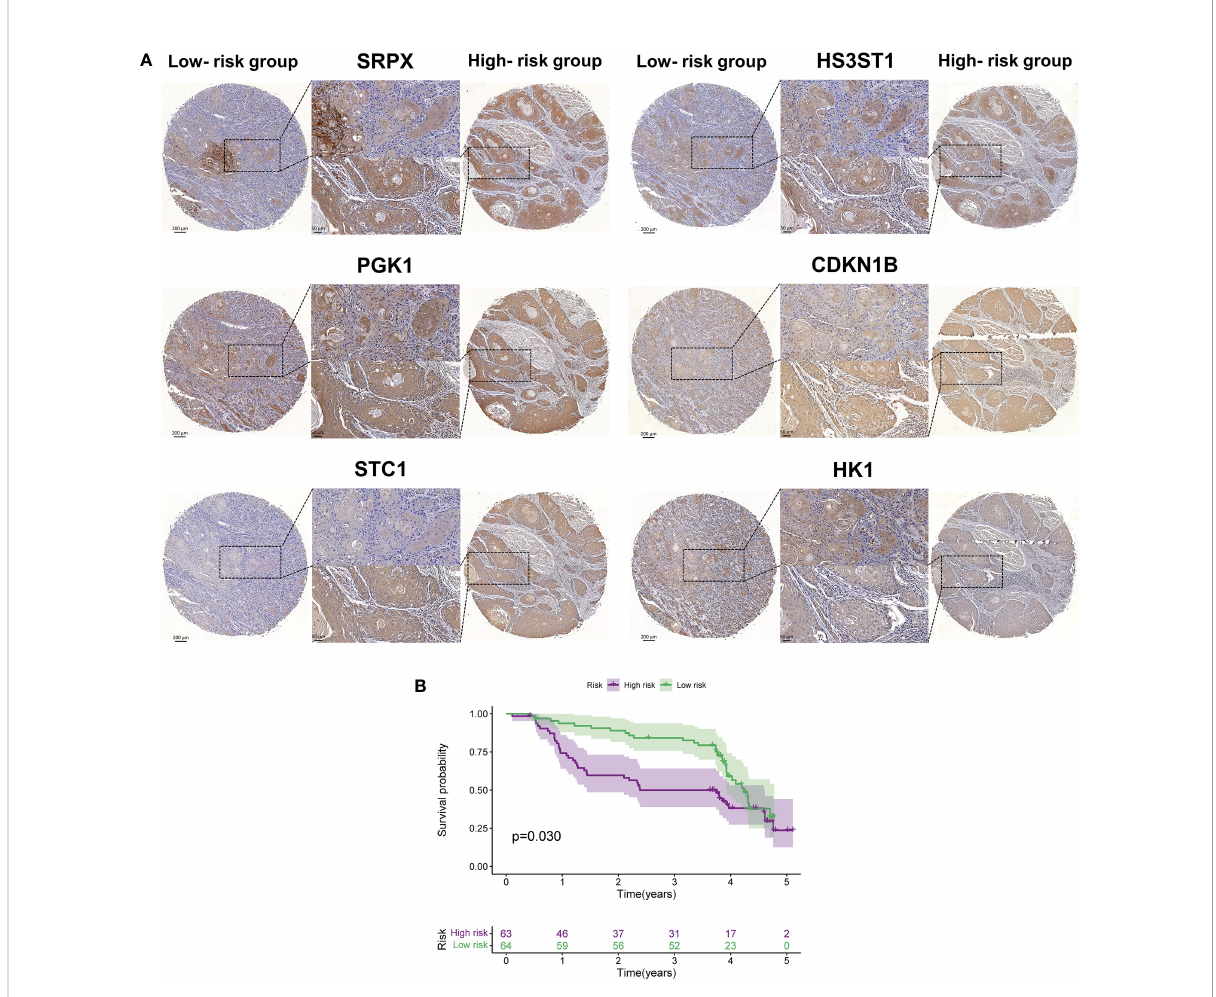
FIGURE 9 The external validation of proteins encoded by six hub HRGs. (A) The expression of six HRGs in the high- and low-risk groups in HNSCC patients. (B) Kaplan-Meier survival curves of HNSCC patients in the high- and low-risk